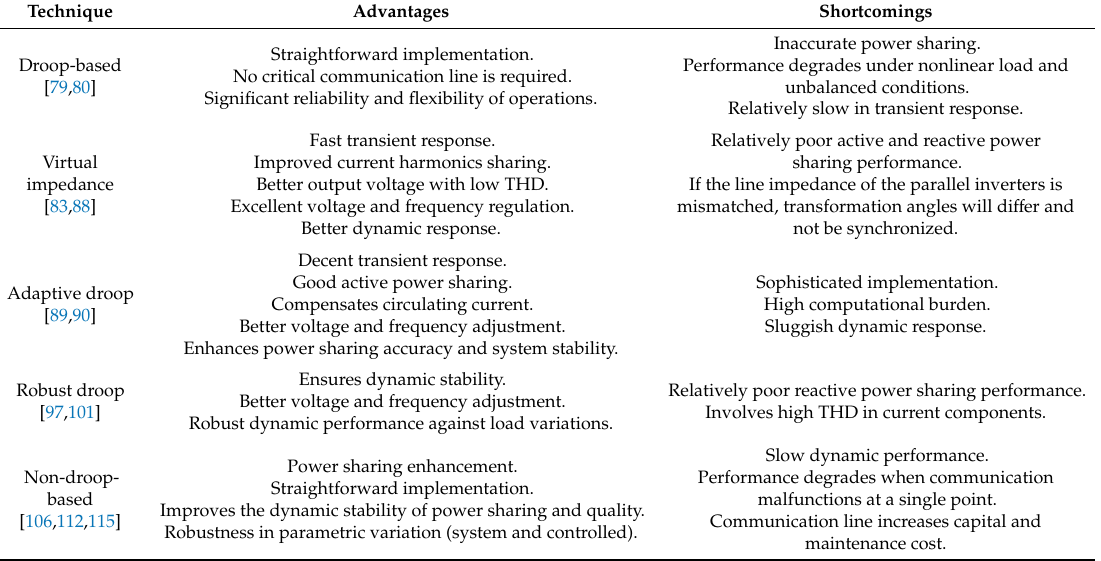
Table 2. The advantages and shortcomings of the power sharing